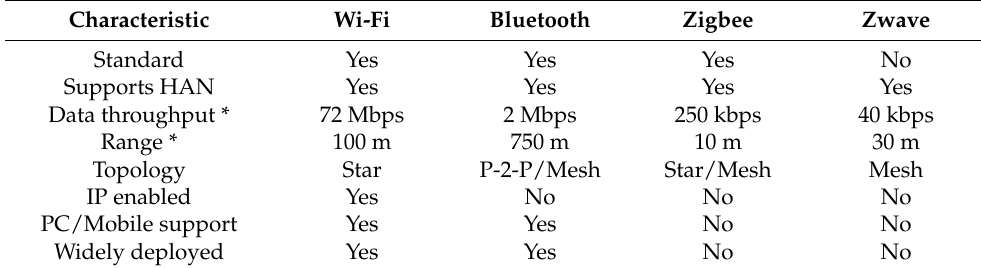
Table 1. Key characteristics of wireless protocols.